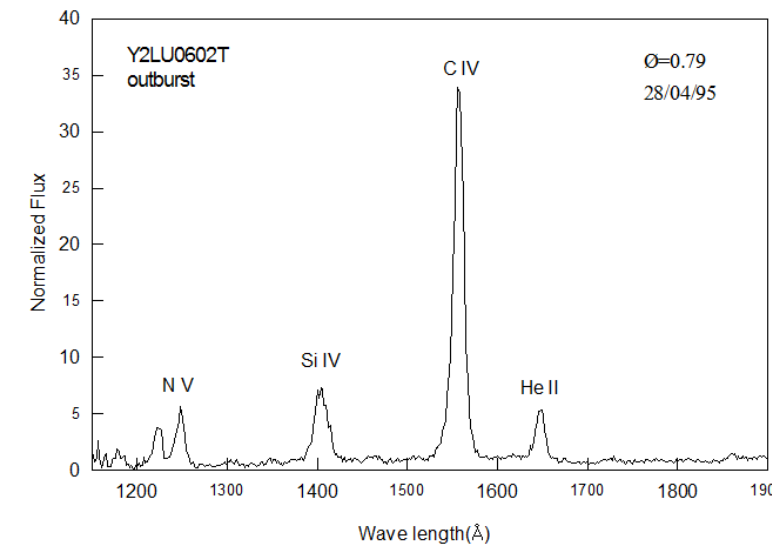
Fig. 1 HST spectrum of DQ Her with outburst flux at phase 0.79.